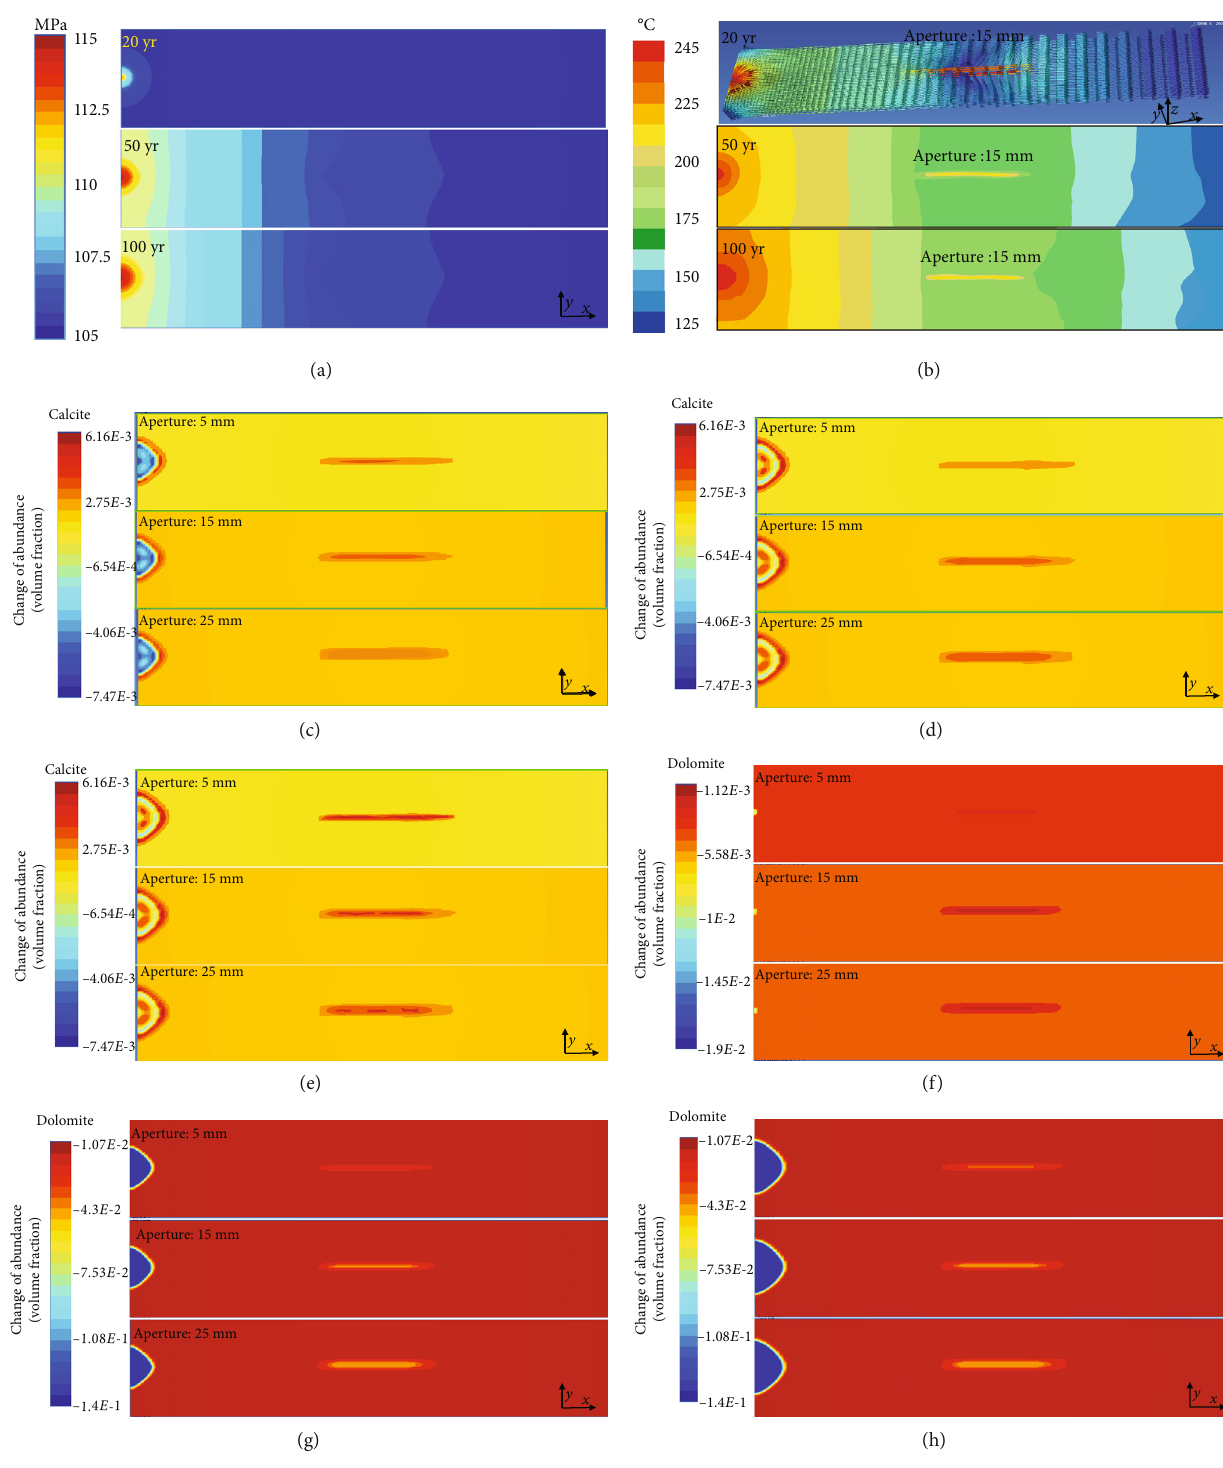
Figure 5: Spatial distribution of geo fl uid fl ow and mineral abundance during simulations of di ff erent-aperture fracture networks (negative values indicate dissolution and positive precipitation). (a) Plans of reservoir pressure variation at di ff erent times; (b) plans of fl ow rate and temperature variations (length of the arrow representing fl ow rate, that is, the longer the arrow, the faster the fl ow rate); (c) changes of abundance of calcite in plans after 10 years; (d) changes of abundance of calcite in plans after 50 years; (e) changes of abundance of calcite in plans after 100 years; (f) changes of abundance of dolomite in plans after 10 years; (h) changes of abundance of dolomite in plans after 50 years; (h) changes of abundance of dolomite in plans after 100